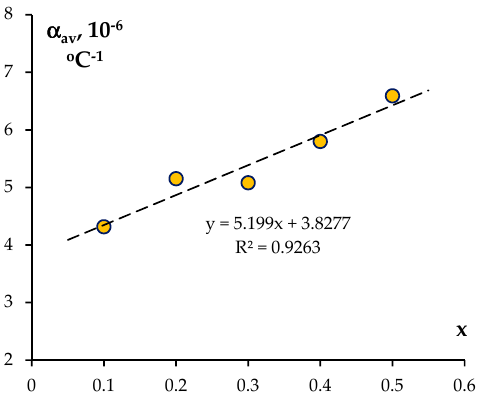
Figure 6. Dependences of the α av parameters on the composition Na 1+2x Zr 2-x Co x (PO 4 ) 3 . In our opinion, such an anomalous behavior of the material is due to the fact that cobalt atoms are located not only in the intraframework L position but also in the M2 position (see Appendix A). Unfortunately, at present, it is impossible to provide an unambiguous answer regarding the nature of the Co distribution between possible L and M2 positions. Single-crystal X-ray diffractometry is the most effective method to decipher the structure. To ensure effective application of this technique, it is necessary to use spec- imens of single crystals at least 30–100 µm in size. Unfortunately, currently, there is no chance to prepare a single crystal of the Na 1+2x Zr 2-x Co x (PO 4 ) 3 compound using the solid- phase method or wet chemistry method.